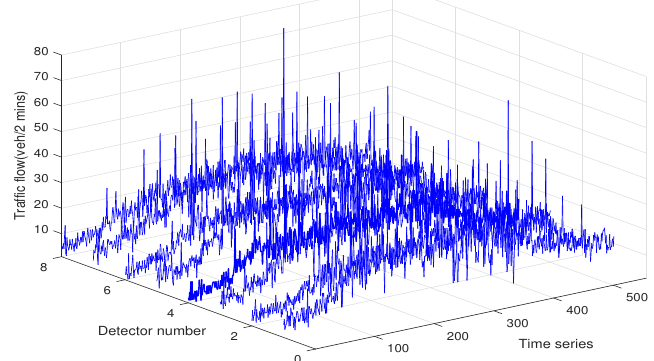
Figure 6. Traffic flow data of eight